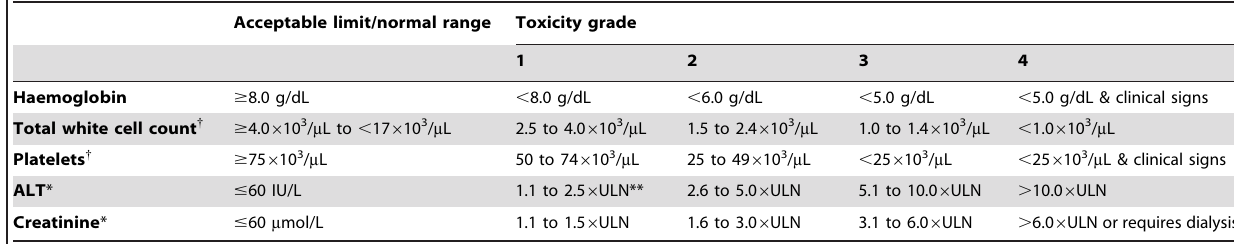
Table 3. Grading scale for laboratory results following